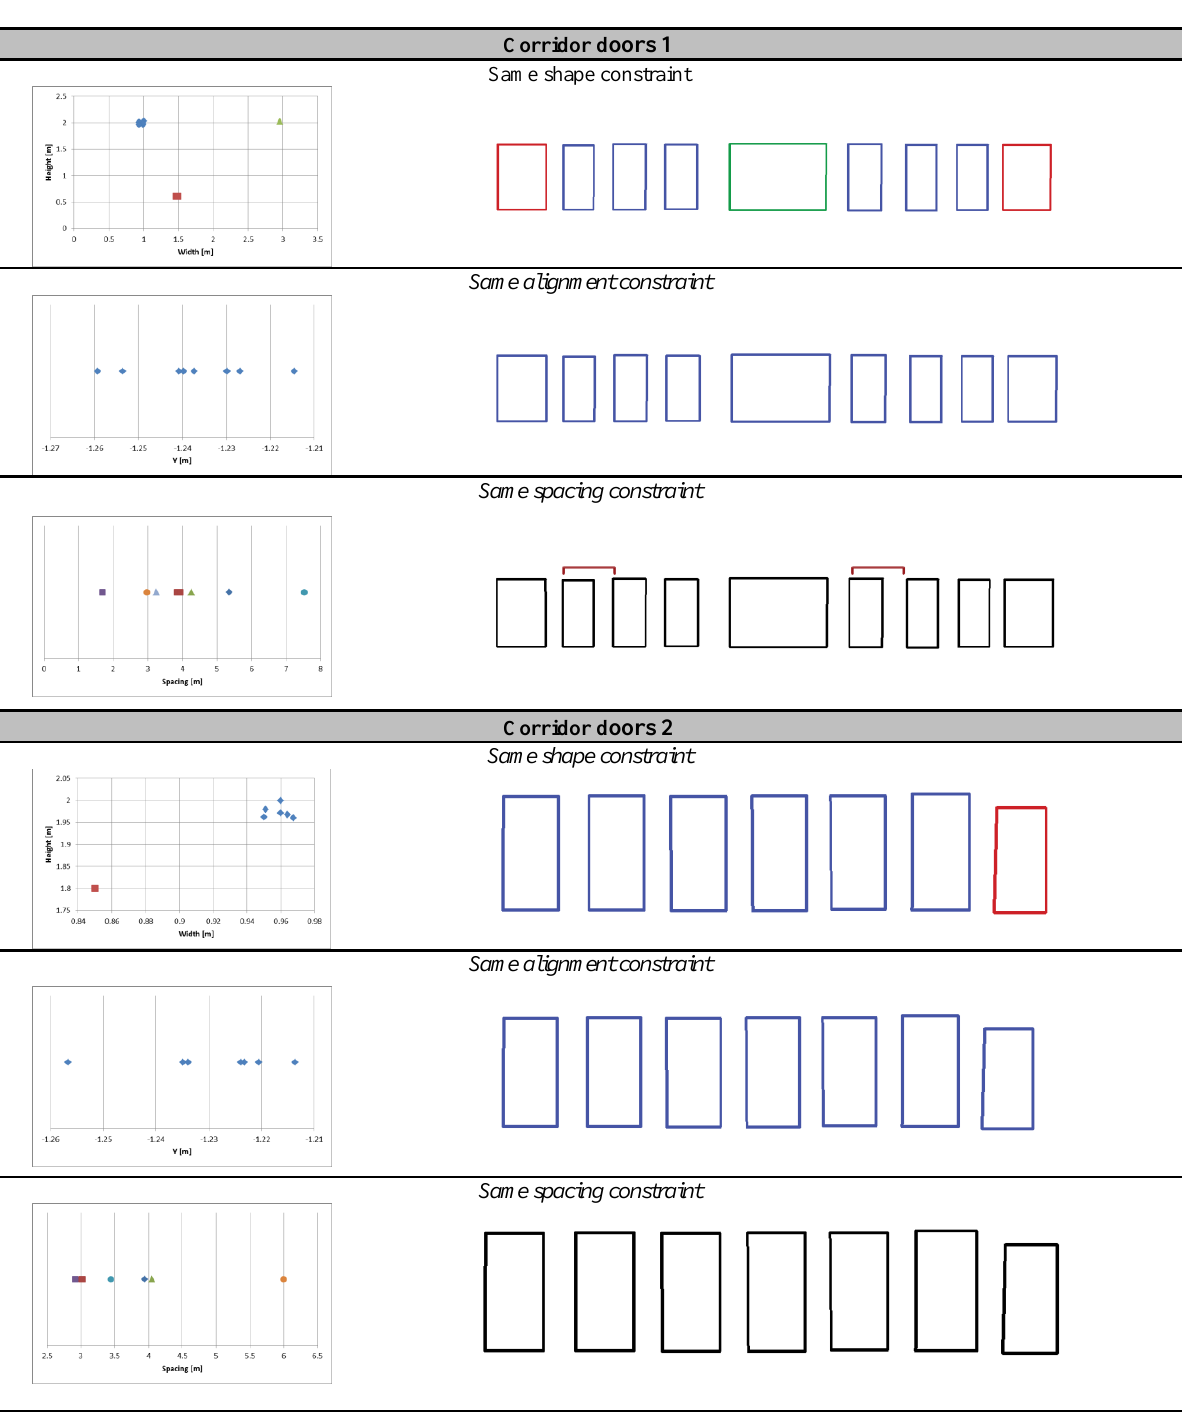
Figure 6. Detected constraints for the building doors in the corridor: the detected clusters with means shift clustering are represented with different colours (left), and the related features are highlighted with the same colour